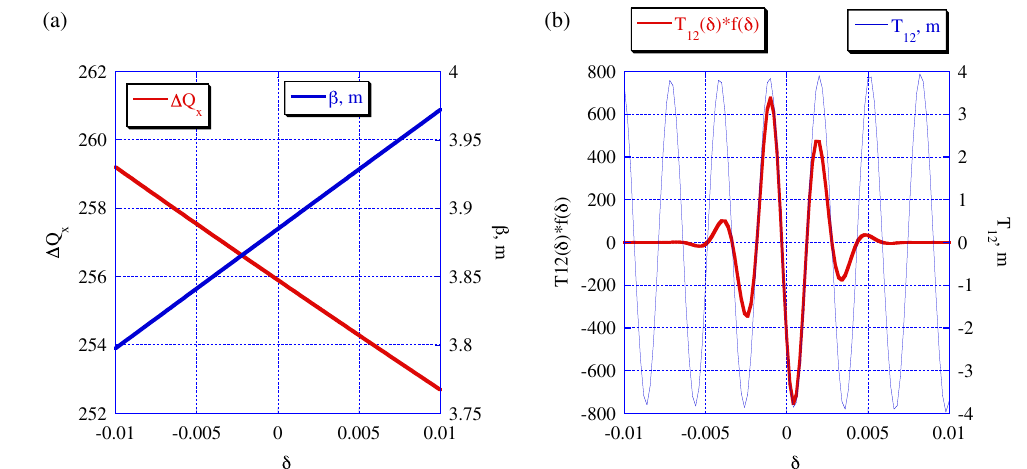
FIG. 8. The FODO beam line optics parameters as a function of the particle momentum for a nominal tune advance per cell ð (cid:3) ¼ 0 Þ ¼ 0 : 2499 : (a) dependence of the total horizontal tune advance (red line), and beta function (blue line) on the relative (cid:2) Q x element (blue line) and its convolution with the momentum distribution momentum deviation (cid:3) ; (b) dependence of the beam line’s T 12 function (red line) on the relative momentum deviation (cid:3)